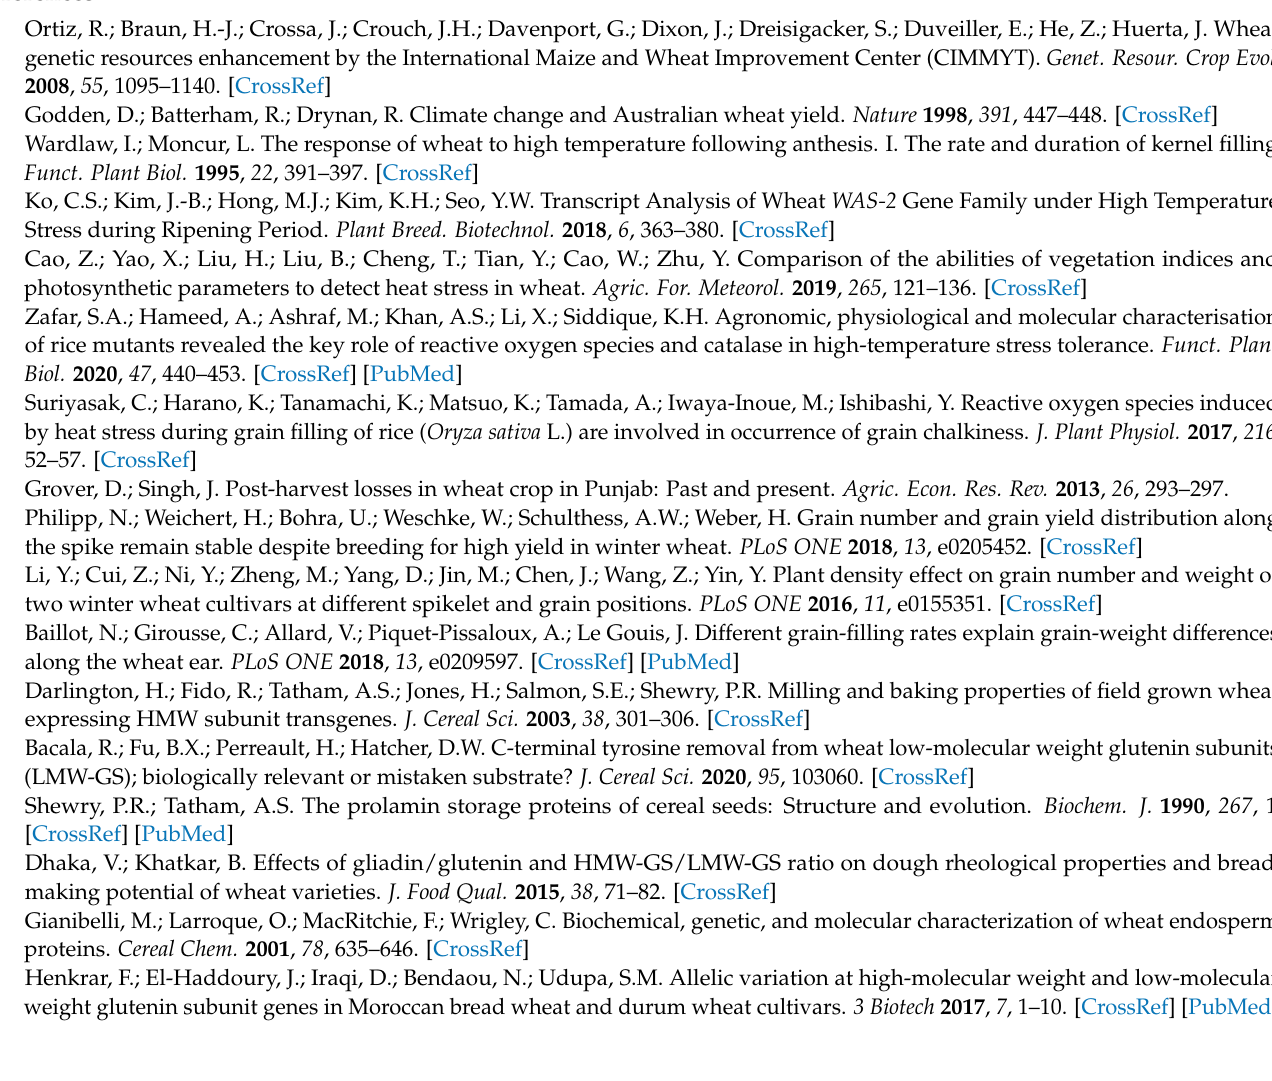
expression patterns. Figure S3: Identification of TaHMW1D using genomic DNA. Figure S4: DNA sequence alignment of TaHMW1D in Keumgang. Table S1: Spots that showed decreased protein levels after high-temperature stress during grain